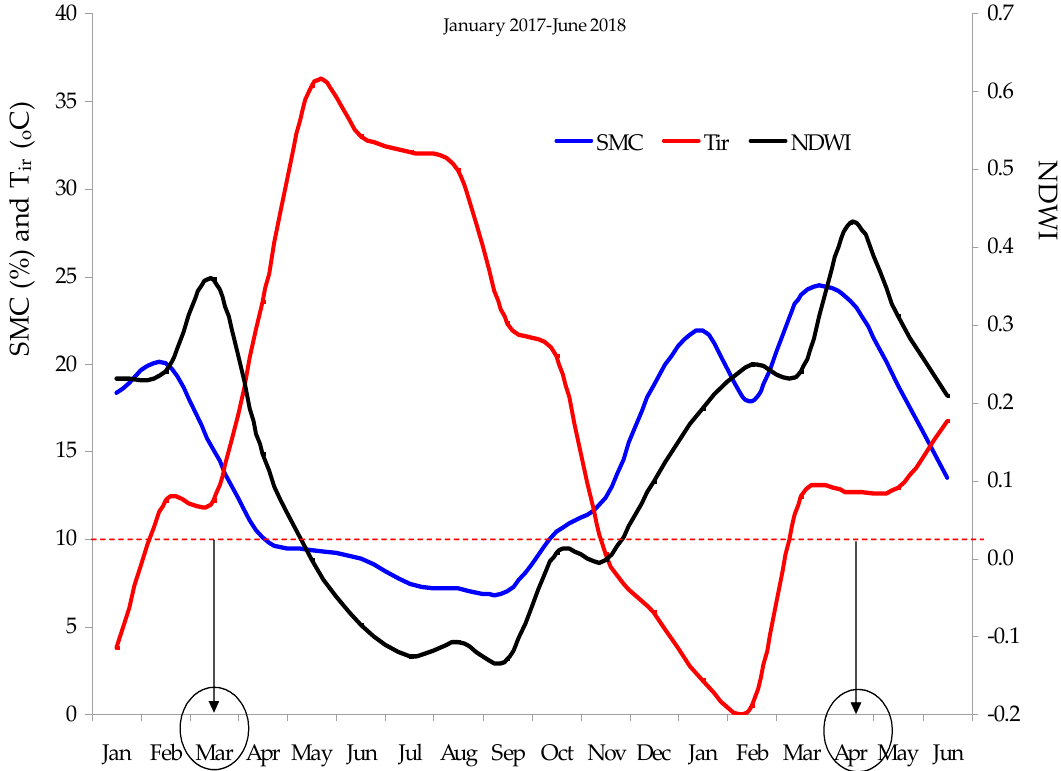
Figure 8. Monthly evolution, between January 2017 and June 2018, of soil moisture content (SMC), pasture surface temperature (T ir ) and normalized difference water index (NDWI). Data are average values of the 12 sampling points. The red dashed line corresponds to the T ir of 10 °C.